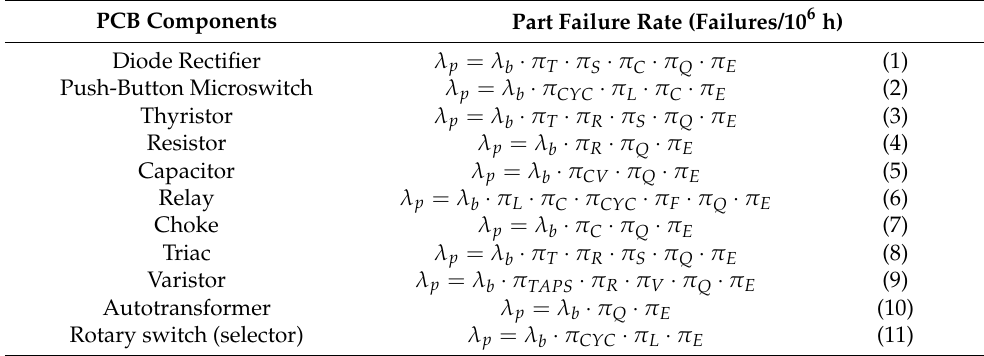
Table 1. Part failure rate for PCB